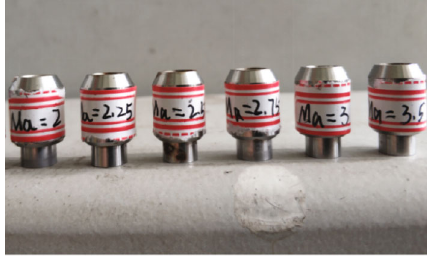
Figure 8: Physical diagram of